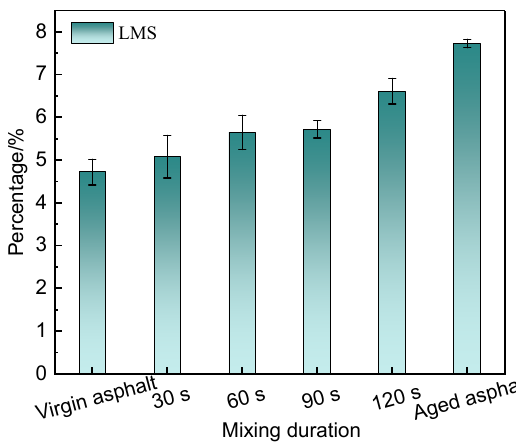
Figure 14. LMS content in the asphalt binder with different mixing durations.